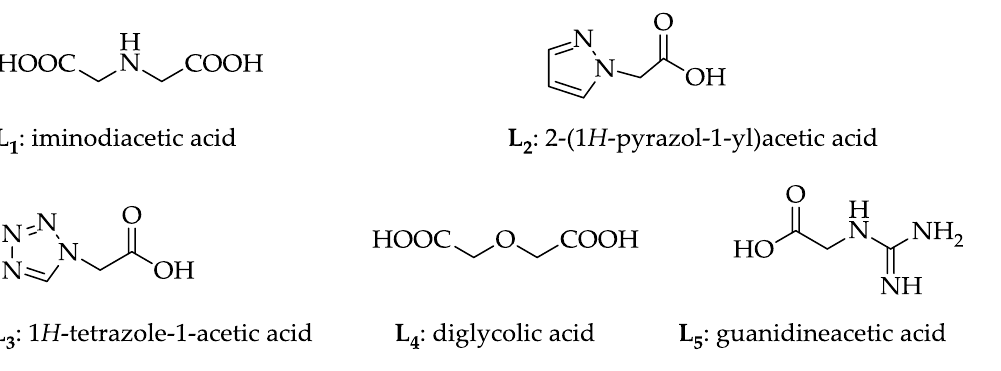
Figure 10. The structure of the five ligands.